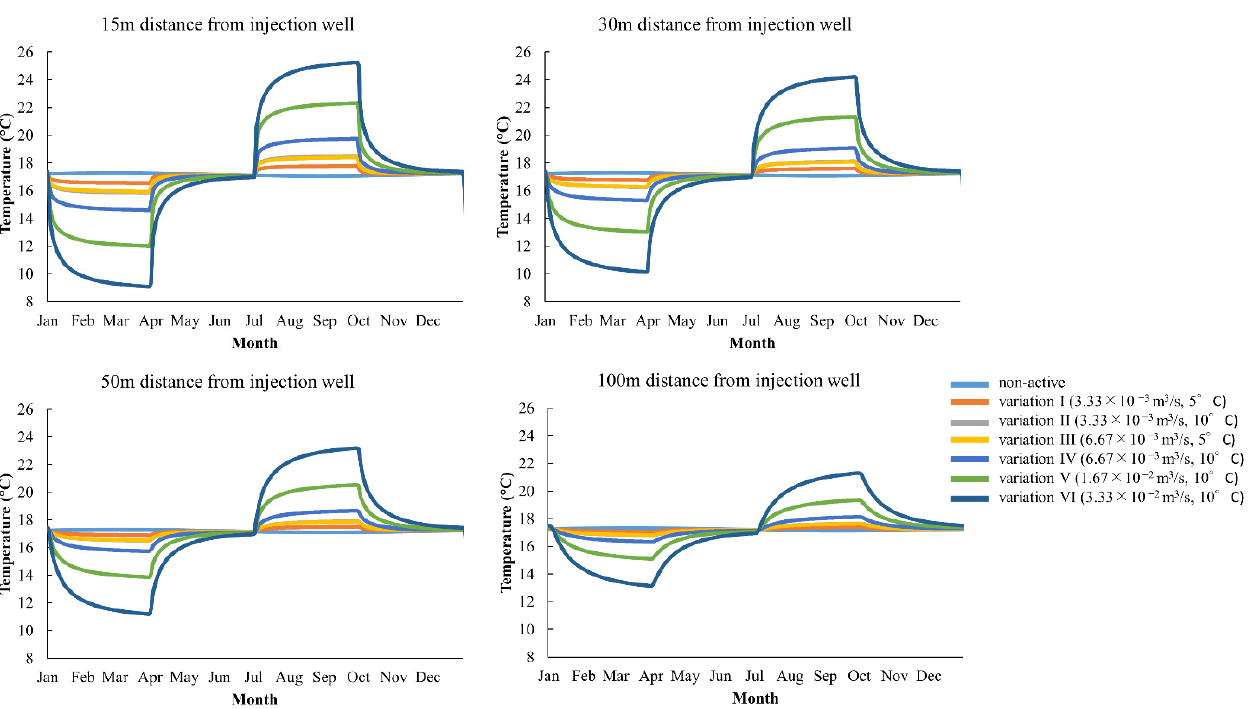
Figure 13. Thermal changes in local model 2 by open-loop GHP used in the downstream region at distances of 15, 30, 50, and 100 m from the injection well, with a variation of pumping rate and water injected temperature.